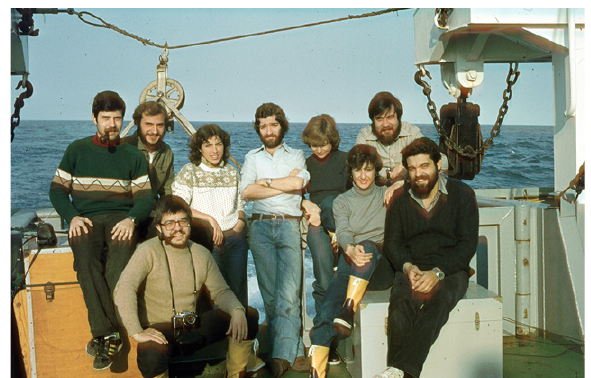
Fig. 1. – Jordi Font on board the R/V García del Cid in March 1982, during the Caron82 cruise in the Catalan Sea. Top row, from left to right: Lluís Miralles, José Manuel Fortuño, Ana Sabatés, Xavier Fusté, Rosa Ras, Jordi Salat. Bottom row: Jordi Font, Balbina Molí, Jordi